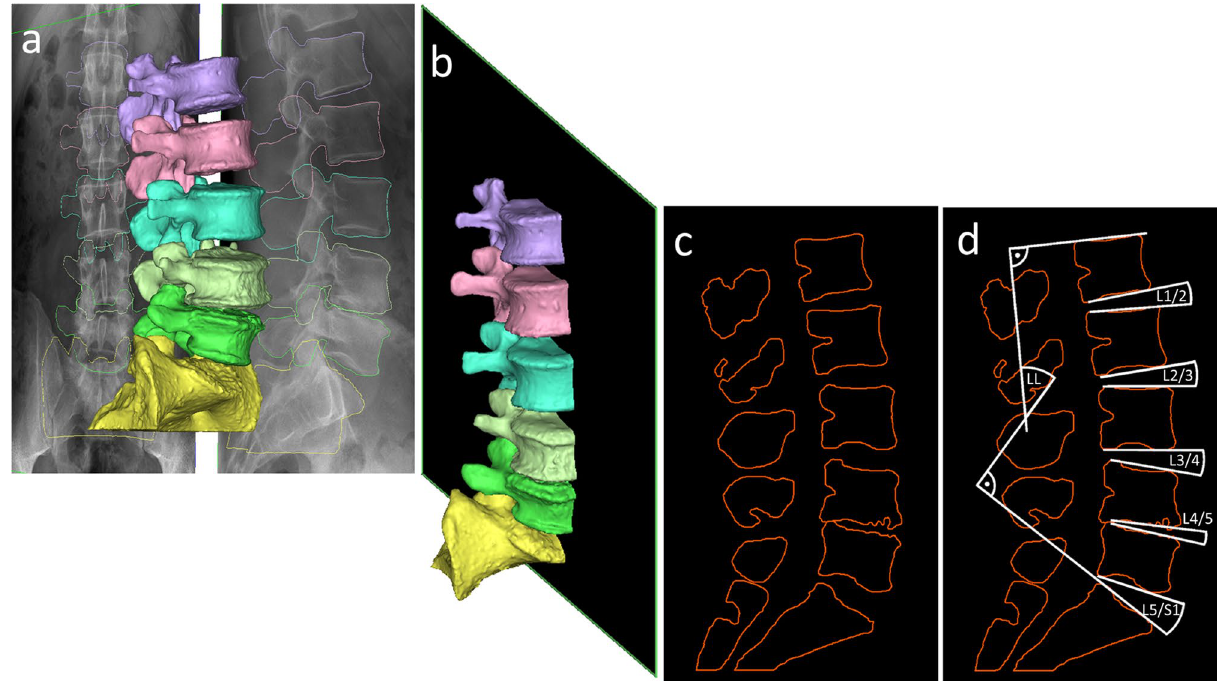
Figure 4. Creation of postregistrational midsagittal sections. ( a ) registered 3D lumbar spine geometry. ( b ) mid- plane used for sectioning. ( c ) resulting postregistrational midsagittal section image. ( d ) intersegmental and LL angle measurements in the postregistrational midsagittal